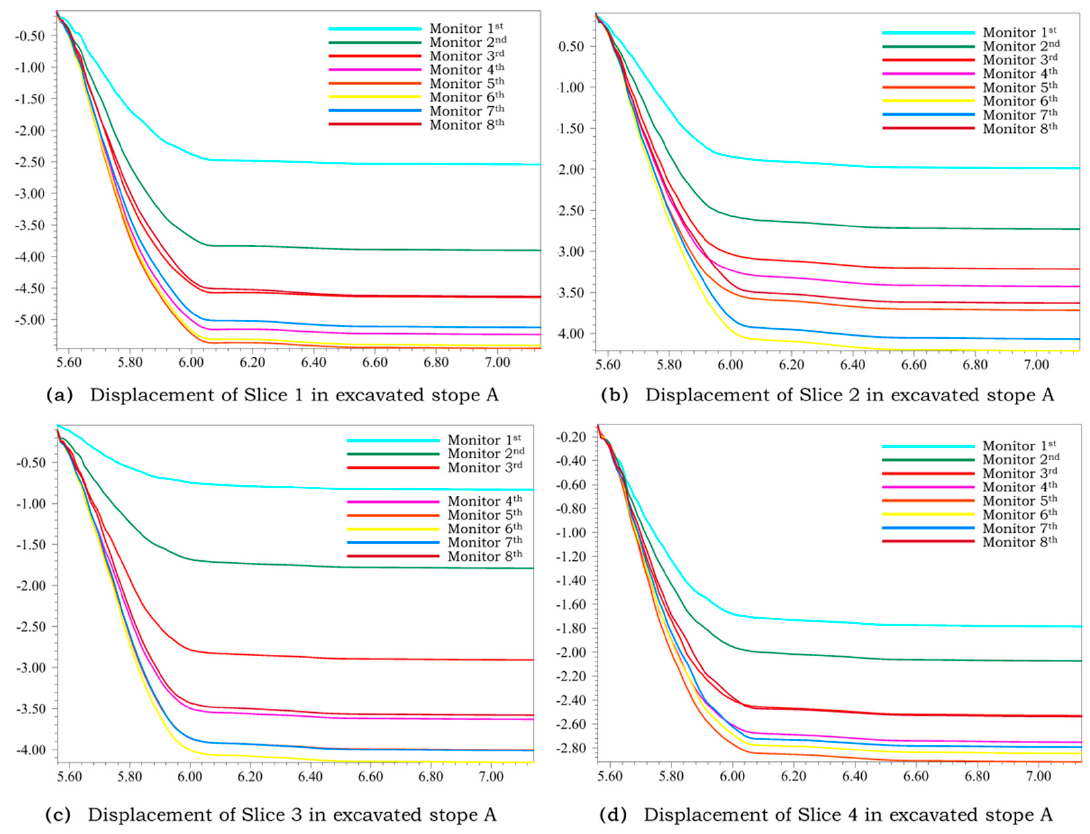
Figure 5. Displacement features of Slices 1 to 4 in excavated Stope A.